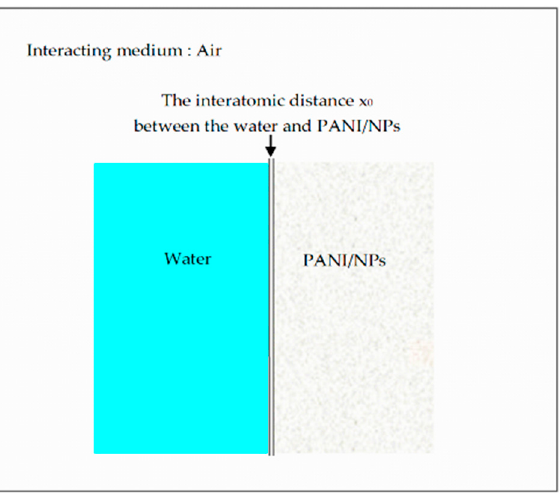
Figure 1. Water and PANI/NPs interacting in air at the separating cut off distance x 0